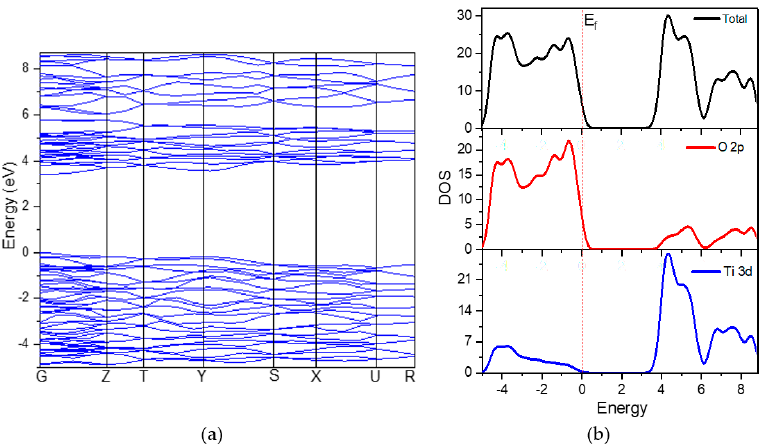
Figure 2. Calculated ( a ) band structure and ( b ) density of states of bulk brookite TiO 2 .